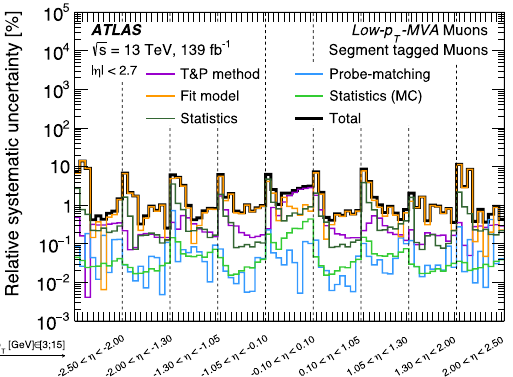
Fig. 11 Relative contributions to the systematic uncertainty in the effi- ciency SFs for muons with 3 < p T < 15 GeV fulfilling the cut-based (left) and multivariate (right) Low - p T selection criteria, obtained from J /ψ → μμ data, as a function of η and p T , and integrated over the